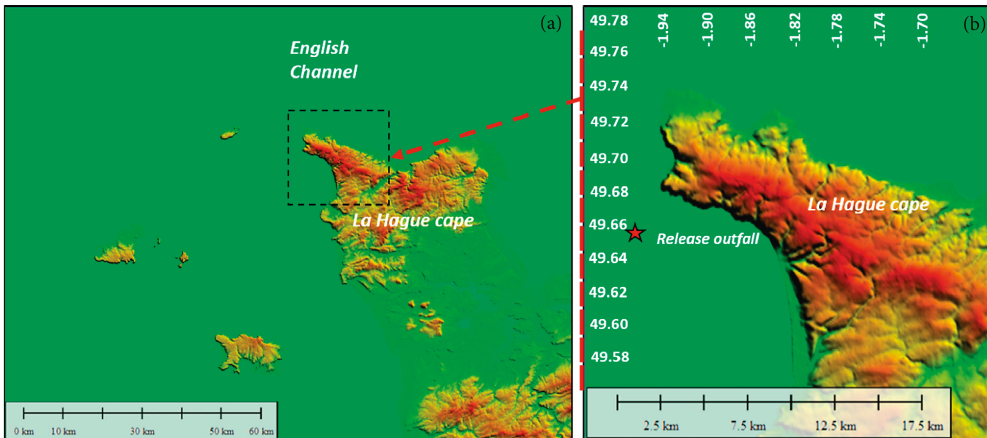
Figure 3: Terrain of the Cap de La Hague. (a) Simulation region in Bailly du Bois et al.’s work. (b) Region of release outfall near the